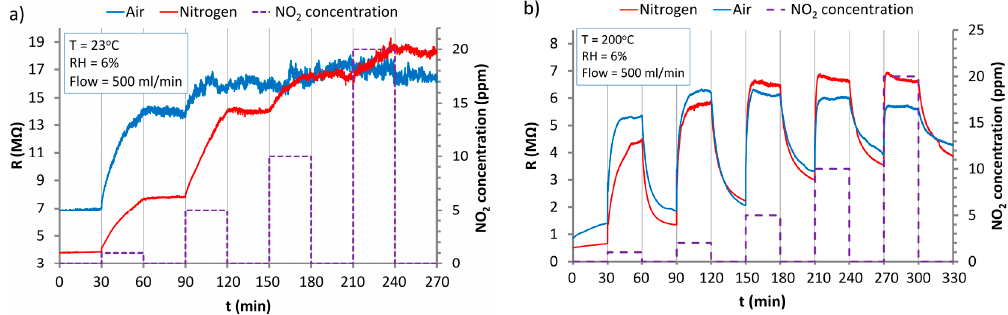
Figure 6. The response of the sensor based on ZnO nanostructures to the action of NO 2 in the atmosphere of synthetic air and nitrogen at: ( a ) room temperature (RT); ( b ) at 200 °C.